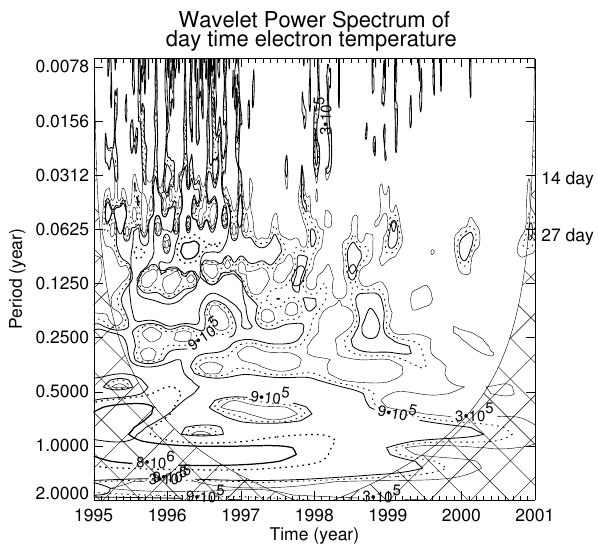
Fig. 9. Wavelet spectra of electron temperature during the daytime. The wavelet scale is marked in years along the y-axis. The power corresponding to each contour is marked in figures. The mesh indi- cates the regions where the edge effect becomes important.